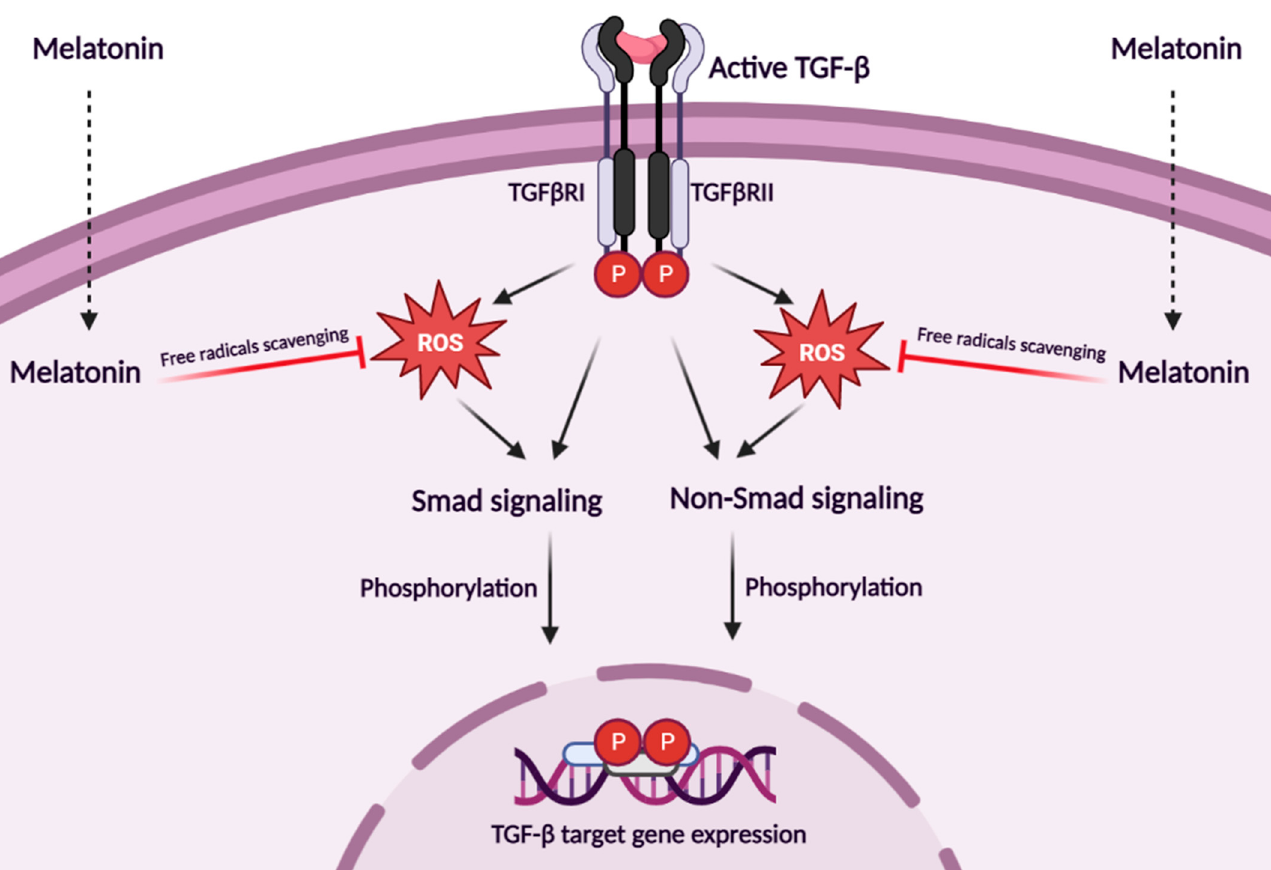
Figure 1. E ff ect of melatonin on the TGF- β signaling. TGF- β can signal via the canonical Smad Figure 1. Effect of melatonin on the TGF- β signaling. TGF- β can signal via the canonical